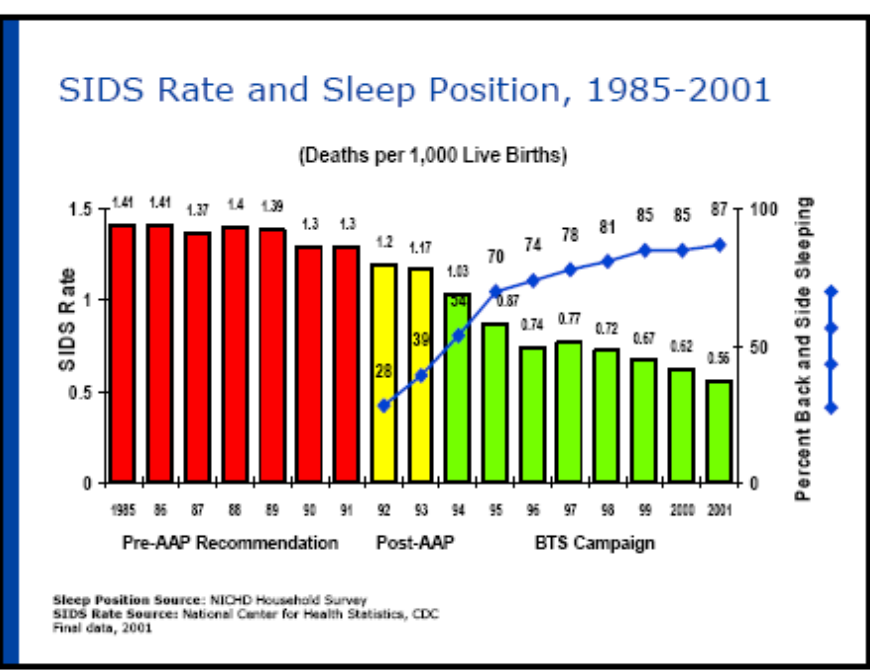
FIGURE 1 . The reported rate for SIDS was already in decline prior to the issuance, in June 1992, of the AAP recommendation to place infants in the supine sleeping position and dropped 26% between 1989 and the start of the BTSC in